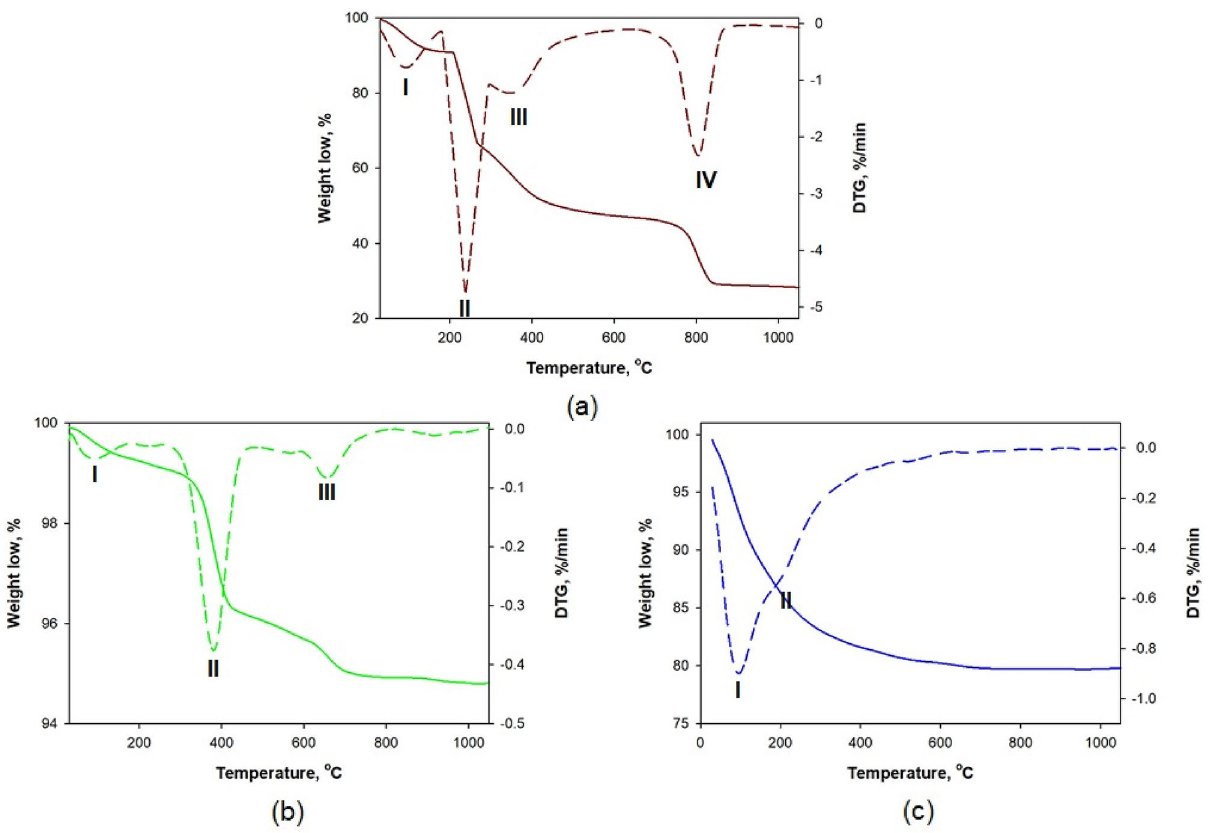
Figure 4. TG/DTG curves of fucoidan ( a ); MgO/Fuc ( b ); and ZrO 2 /Fuc ( c